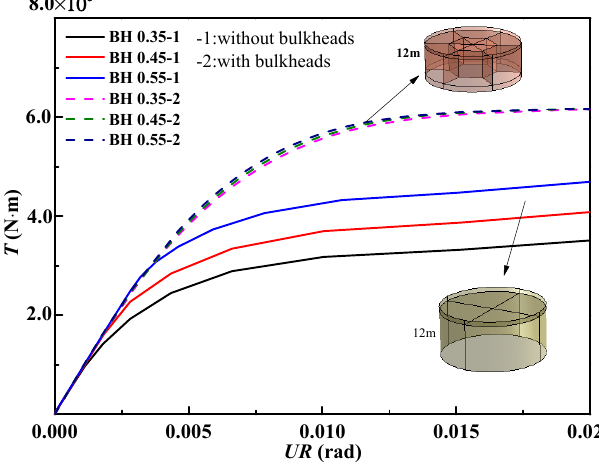
Figure 12. The rotation-torque curves under di ff erent friction coe ffi cients.